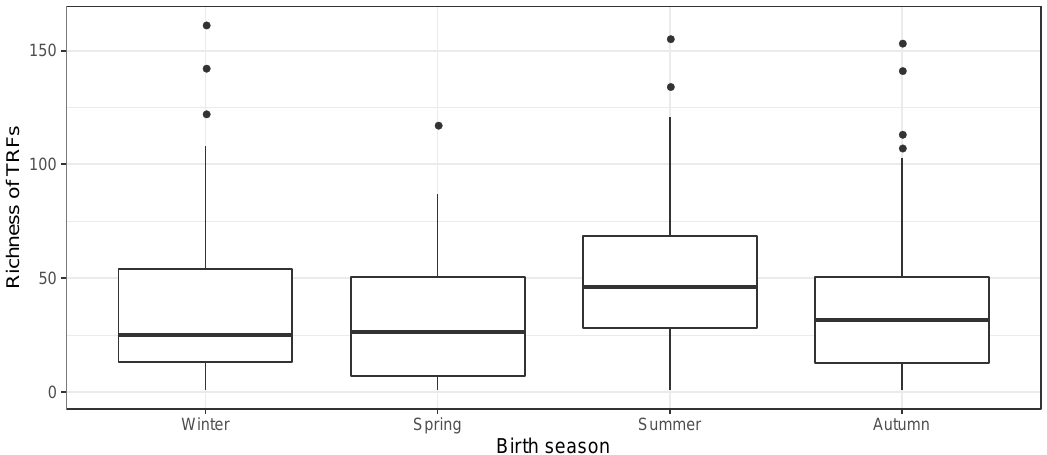
Figure 2. Season of birth and bacterial richness. Number of terminal restriction fragments (TRFs) observed per airway sample in 328 asymptomatic 1-month old neonates.